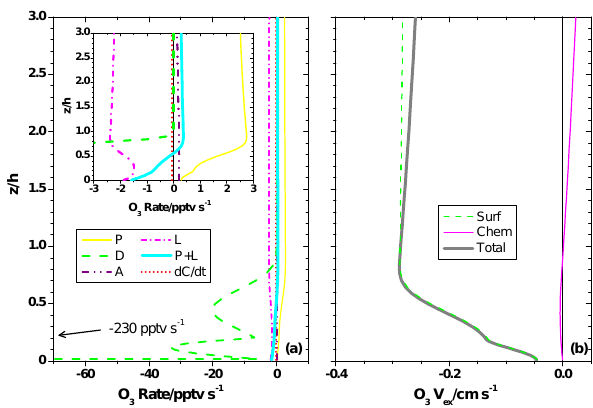
Fig. 6. (a) Modeled profiles of components of the instantaneous rates of change for ozone during the hot period. Contributions in- clude chemical production (yellow solid line), chemical loss (ma- genta dash-dotted line), deposition (green dashed line), advection (purple dash-dot-dotted line) and storage (red dotted line). Also shown is the sum of chemical production and loss (thick cyan line). Ground deposition extends beyond the scale ( − 230pptvs − 1 ) . The inset provides a zoomed-in view of the same model results. (b) Con- tributions to modeled ozone exchange velocity profile for the hot pe- riod, including surface (green dashed line) and chemical (magenta solid line) processes, as well as the net exchange velocity (thick gray